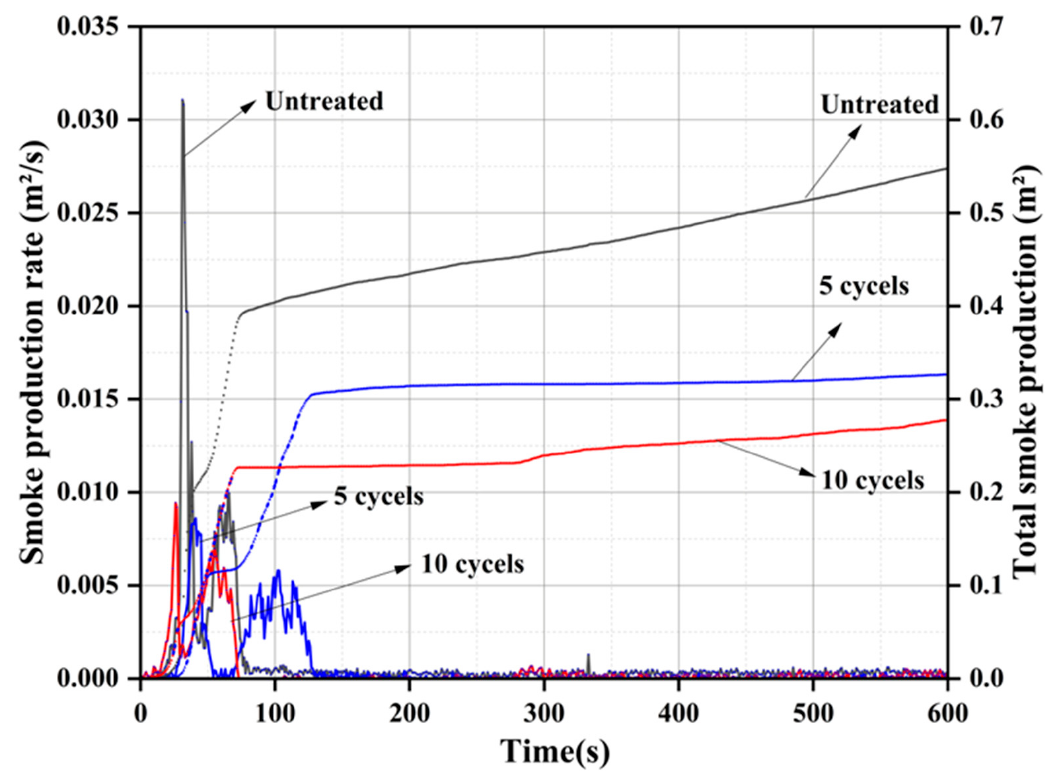
Figure 9. Smoke production rate and total smoke production of untreated and treated wood.